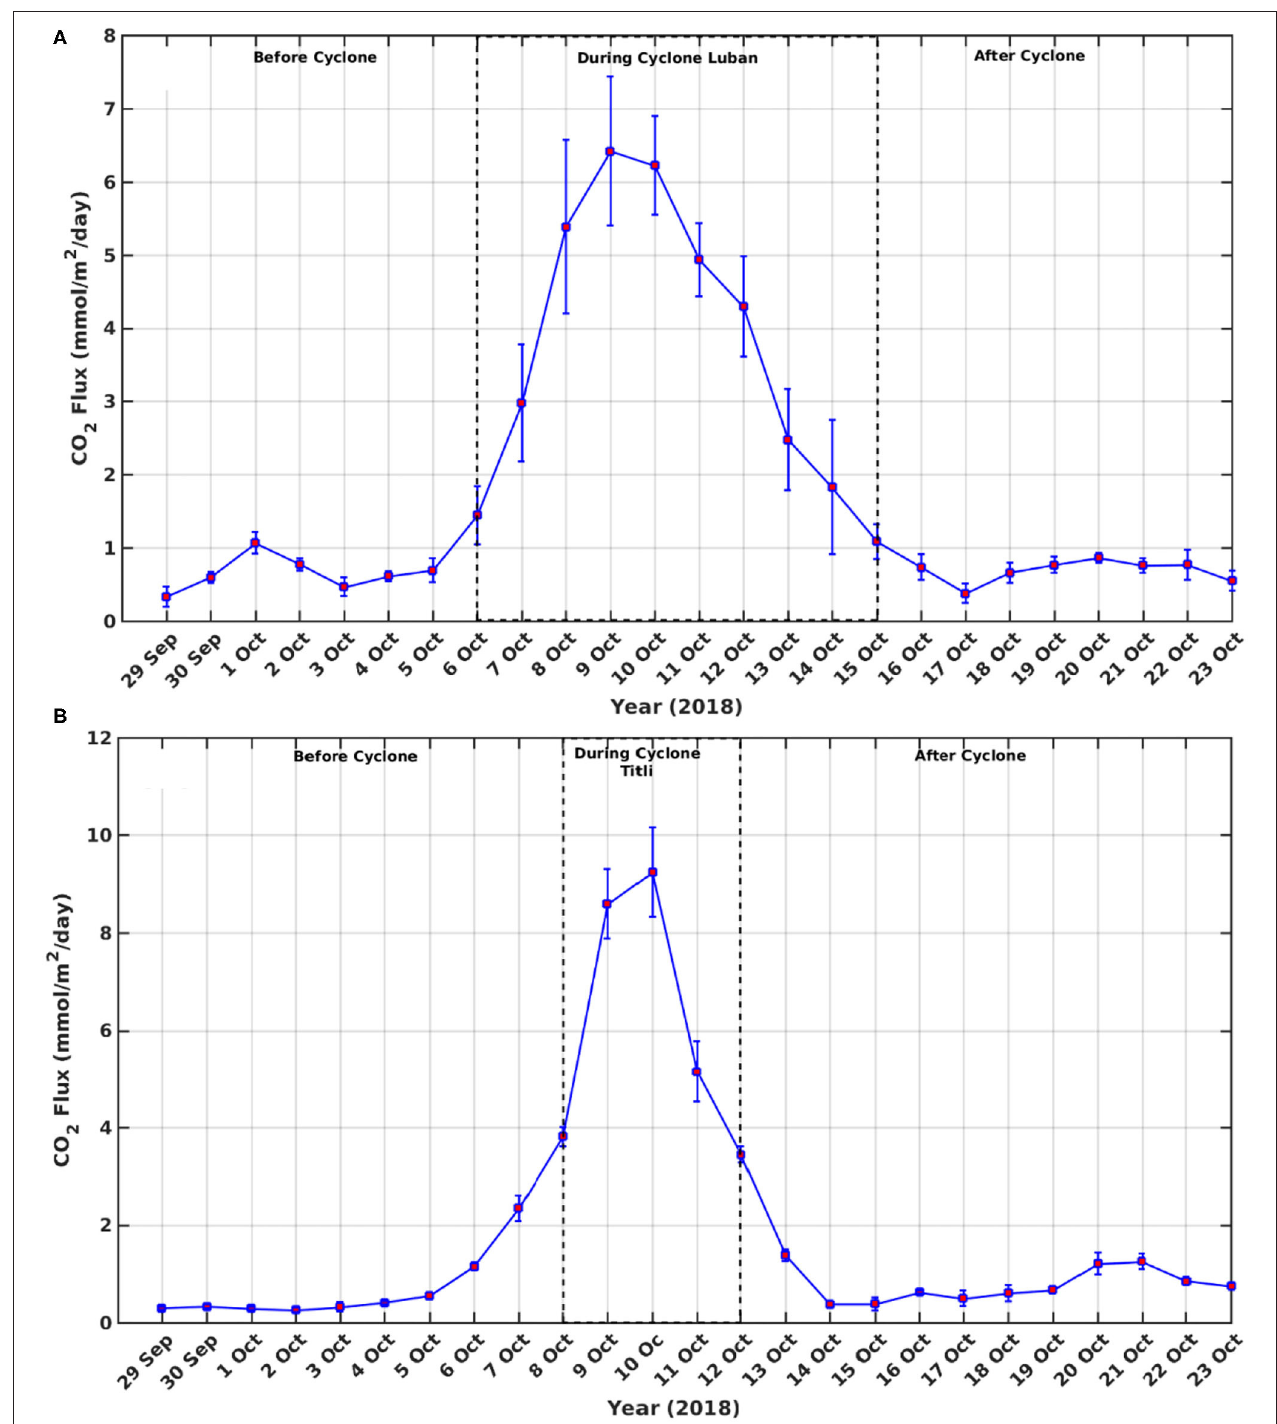
FIGURE 8 | Box-averaged daily CO 2 flux (mmol/m 2 /day) over the box region before, during, and after the passage of cyclones Luban (A) and Titli (B) from September 29 to October 23, 2018. The box with a black broken line over the curve indicates the period of the cyclone.